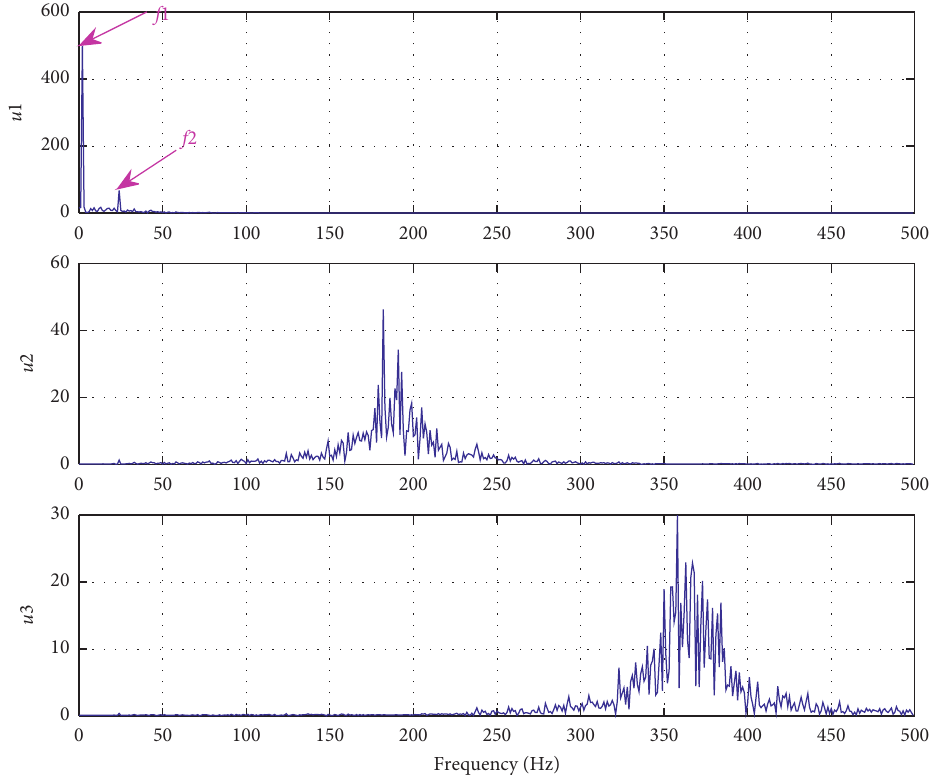
Figure 6: The spectrum of each mode decomposed by traditional VMD.